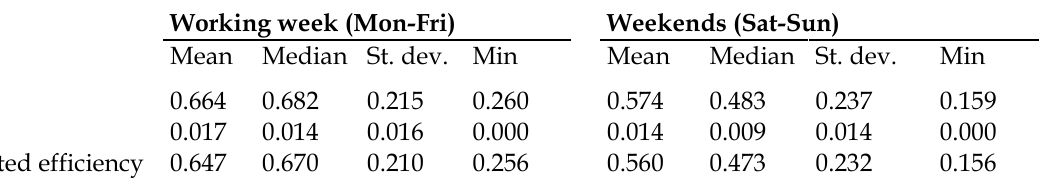
Table 3. Efficiency